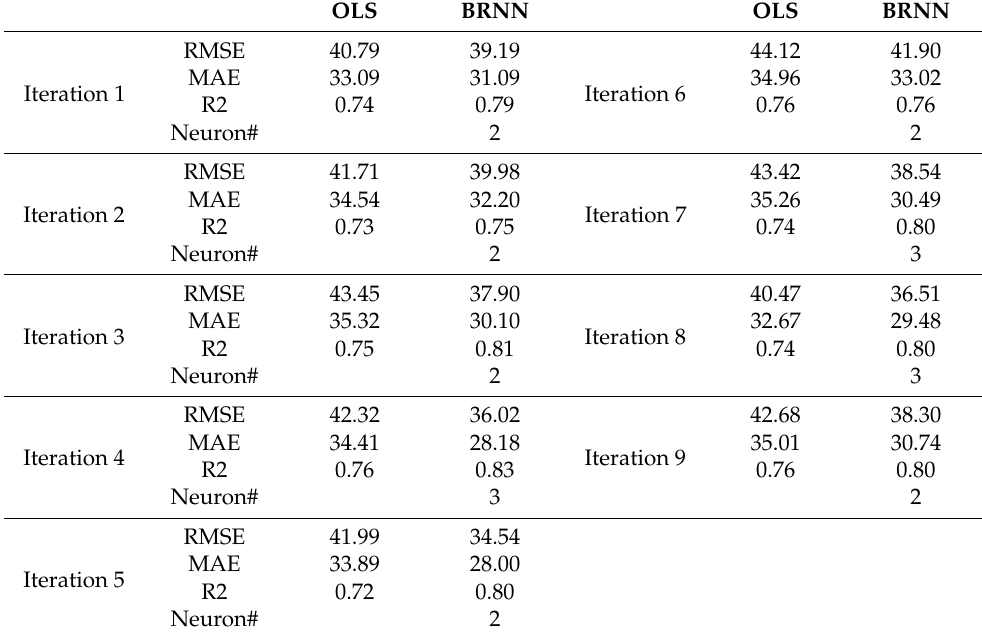
Table 5. Error Indicators (RMSE and MAE) between BRNN and OLS. OLS BRNN OLS BRNN RMSE 40.79 39.19 Iteration 1